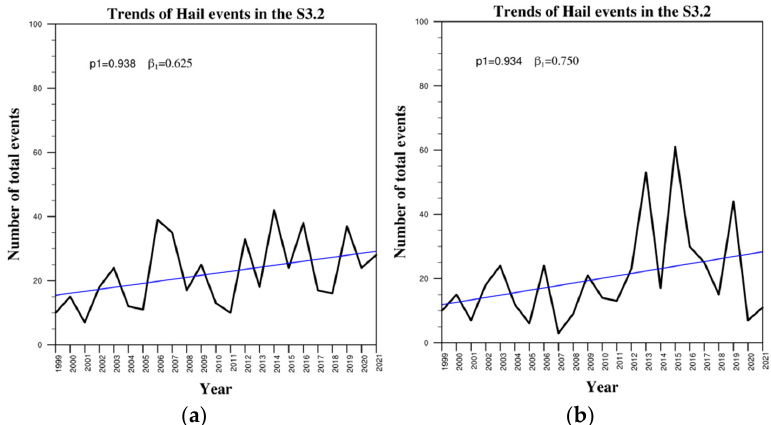
Figure 12. Temporal evolution of the annual number of H events for the sector 3.2 considering the time series-1 N15-N18-NPP ( a ), and time series-3 N15-MOA-MOC ( b ). Blue line displays the tendency of series.